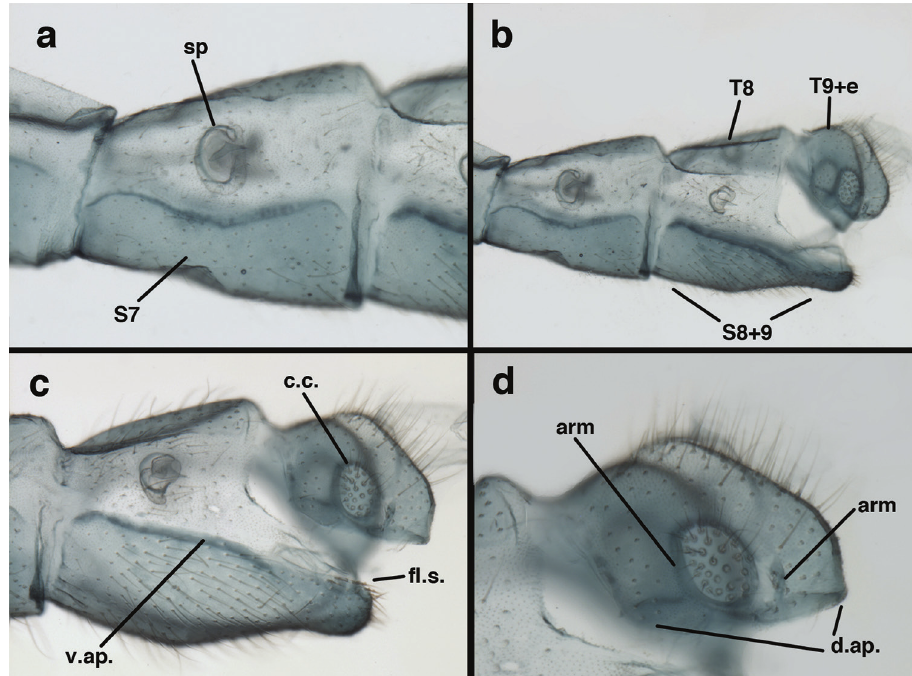
Figure 7. Ungla adamsi Tauber, sp. n. Mature male abdomen, lateral, ( a ) segment A7, with enlarged spiracle and concave sternite ( b ) segments A7-A9 ( c ) terminus ( d ) ninth tergite + ectoproct. c.c. callus cerci d.ap. dorsal apodeme fl.s. flanged setae sp spiracle S7 seventh sternite S8+9 fused eighth and ninth sternites T8 eighth tergite T9+e fused ninth tergite and ectoproct v.ap. ventral apodeme (all: Peru, Machu Picchu, holotype,